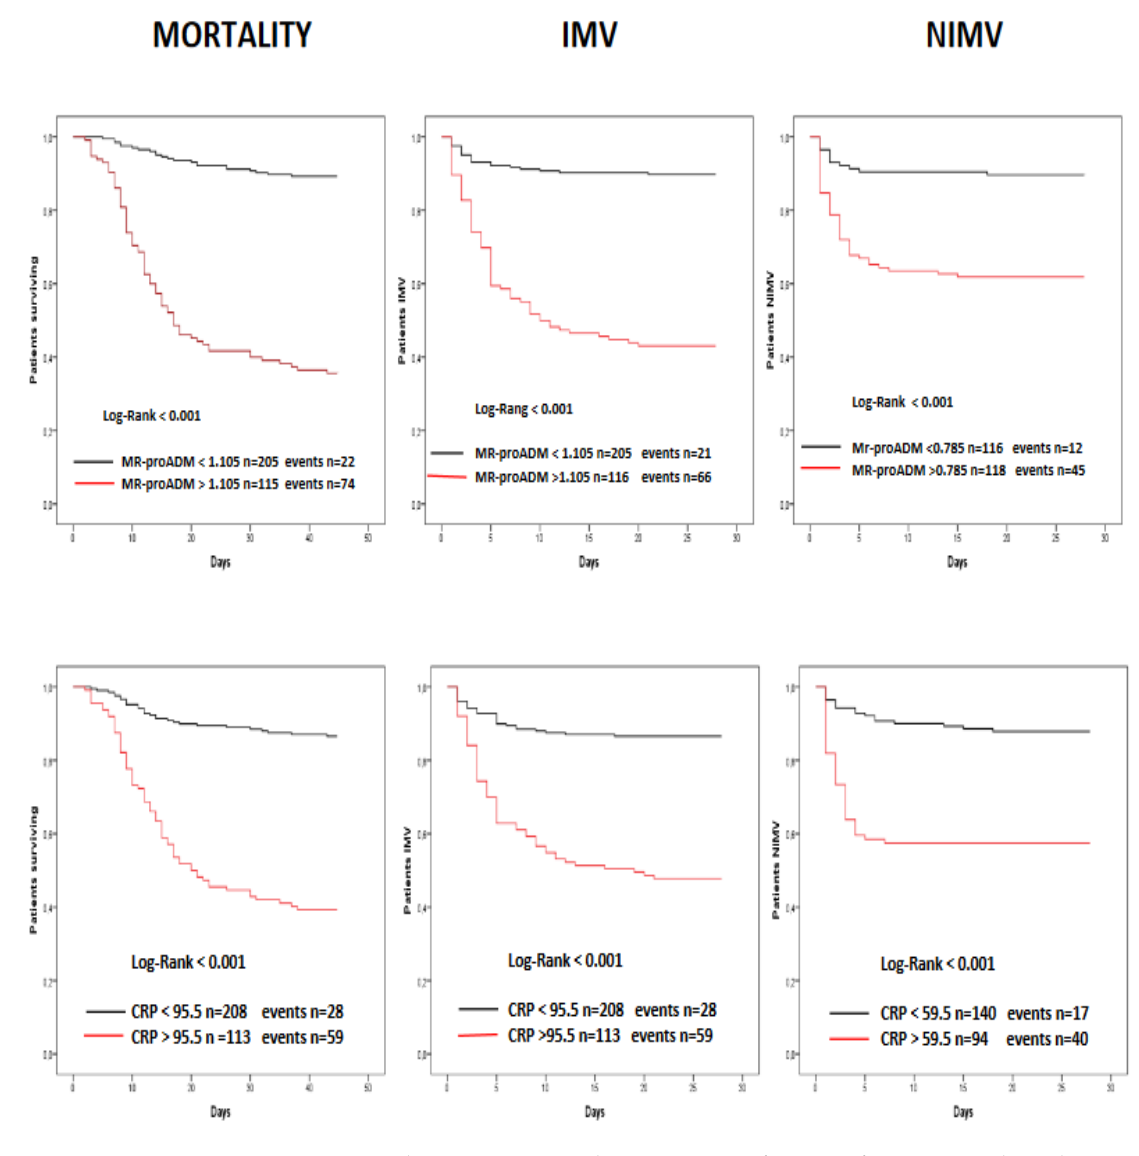
Figure 2. Kaplan–Meier survival curves. Stratification of patients with mid-regional proadrenomedullin (MR-proADM) levels greater or less than 1.105 nmol/L and C-reactive protein (CRP) levels greater or less than 95.5 mg/L at admission in the Emergency Department. IMV, Invasive Mechanical Ventilation; NIMV, Non-Invasive Mechanical Ventilation.